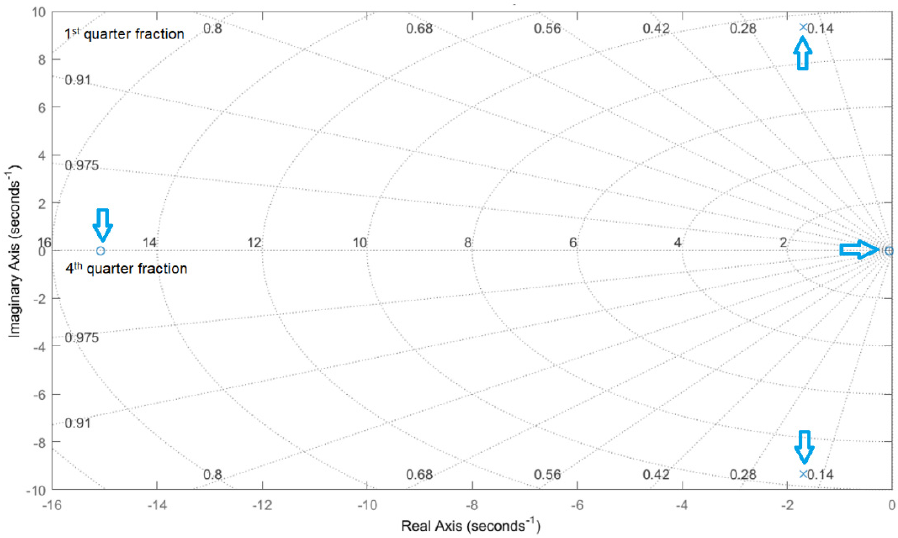
Figure 13. Pole–zero map.